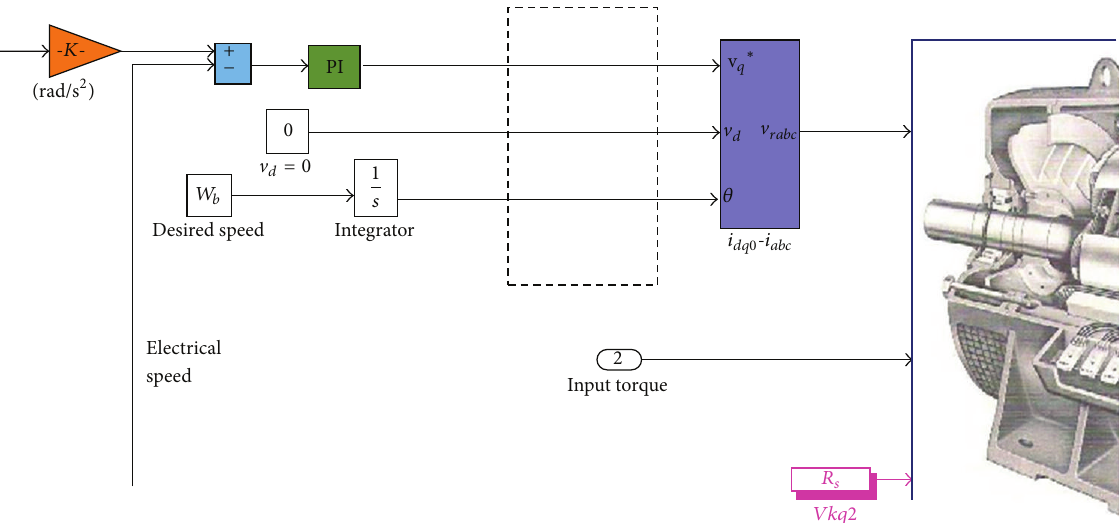
Figure 9: Inner loop of speed control for synchronous generator operation.